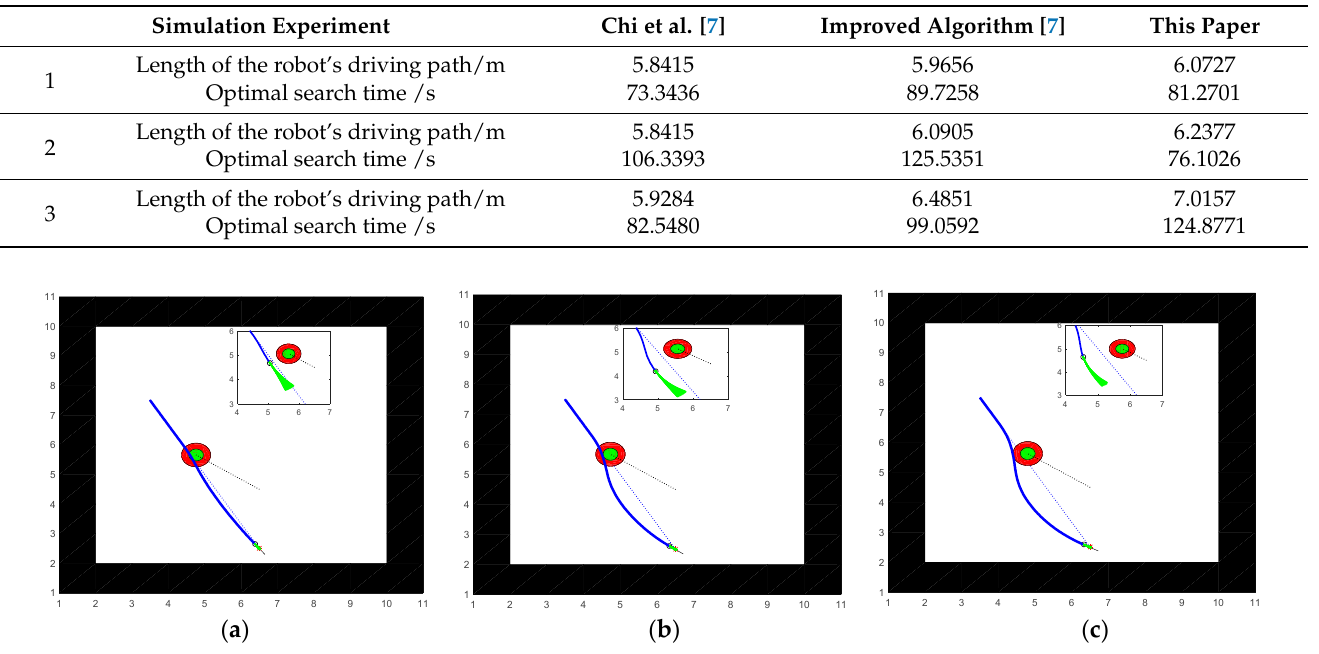
Figure 21. Comparison of path planning results for unknown dynamic environment 1; ( a ) Chi et al. [7]; ( b ) Improved algorithm [7]; and ( c ) This paper.